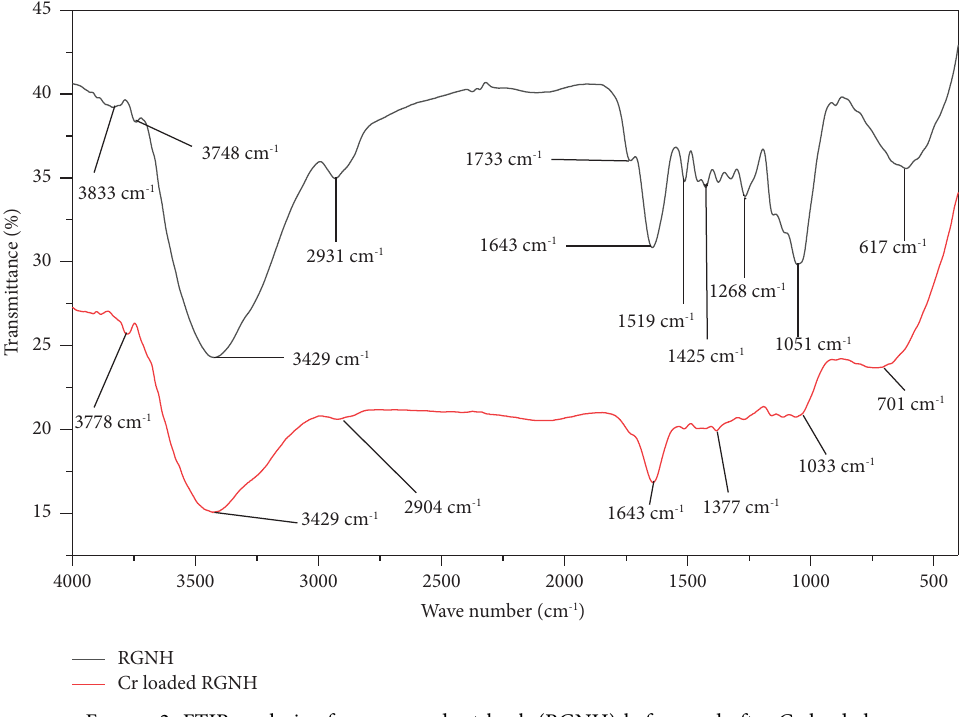
Figure 2: FTIR analysis of raw groundnut husk (RGNH) before and after Cr